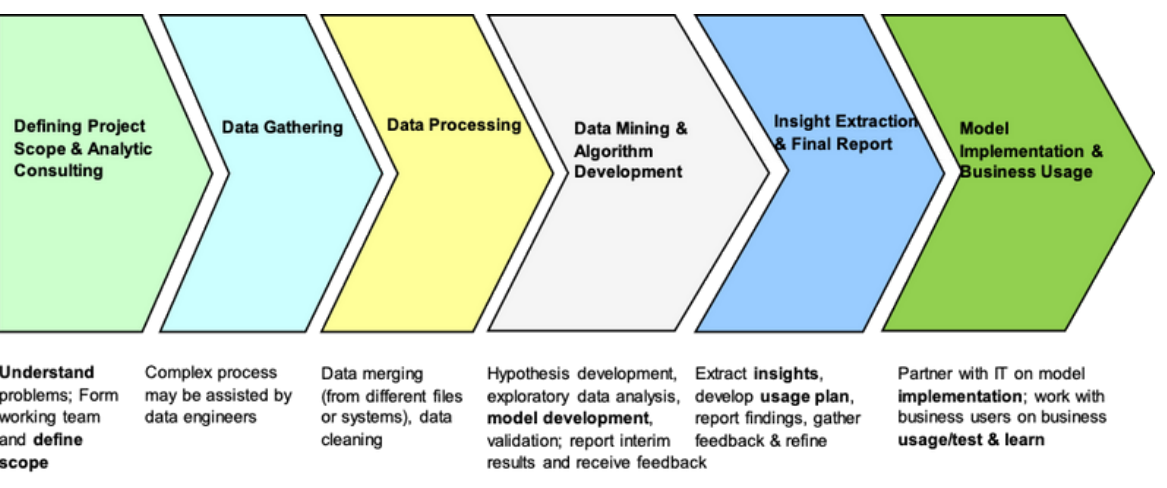
Figure 2. Data Science Project